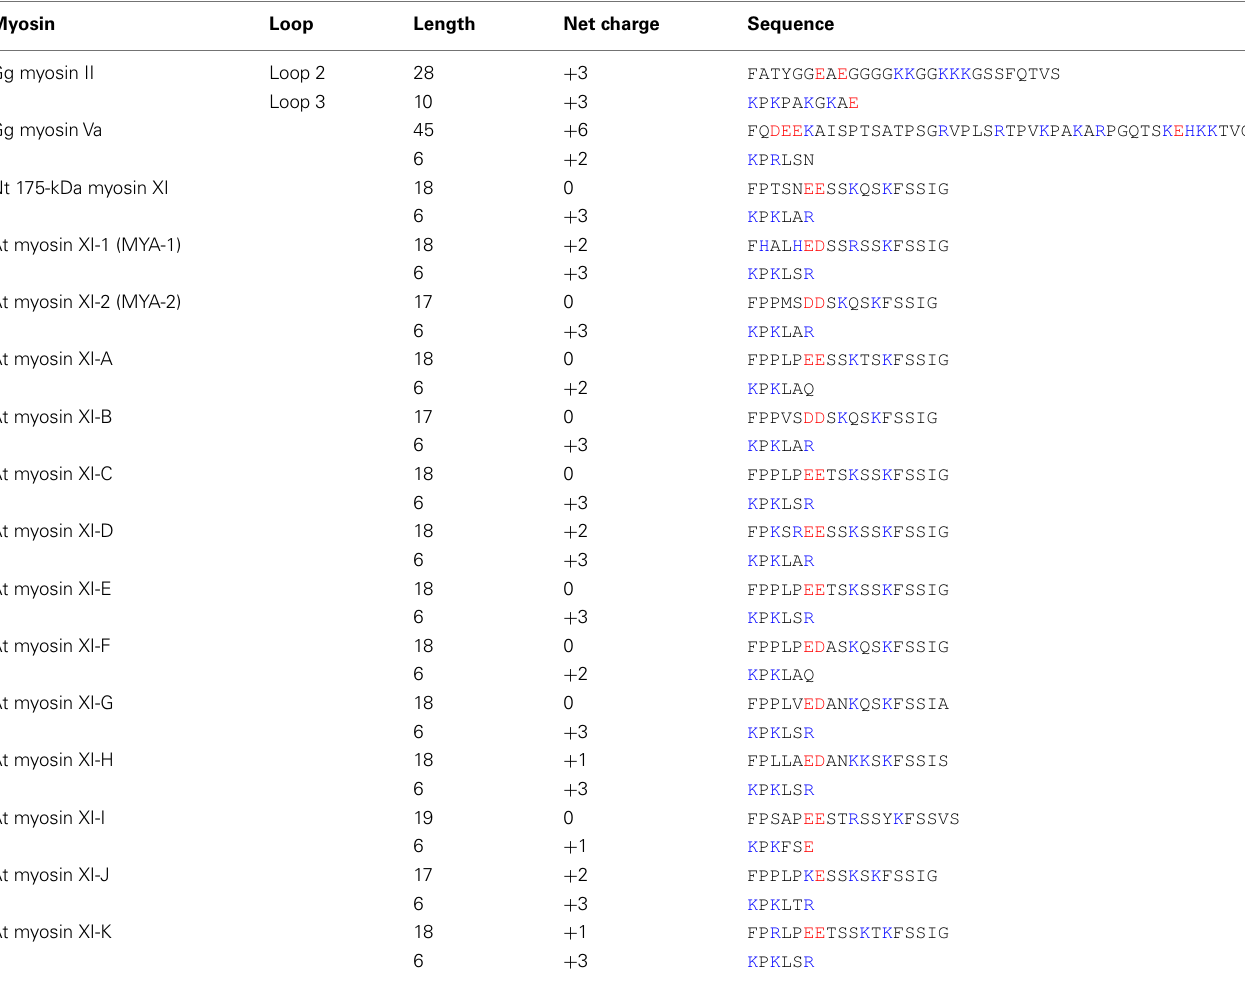
Table 2 | Sequences of loops 2 and 3 of